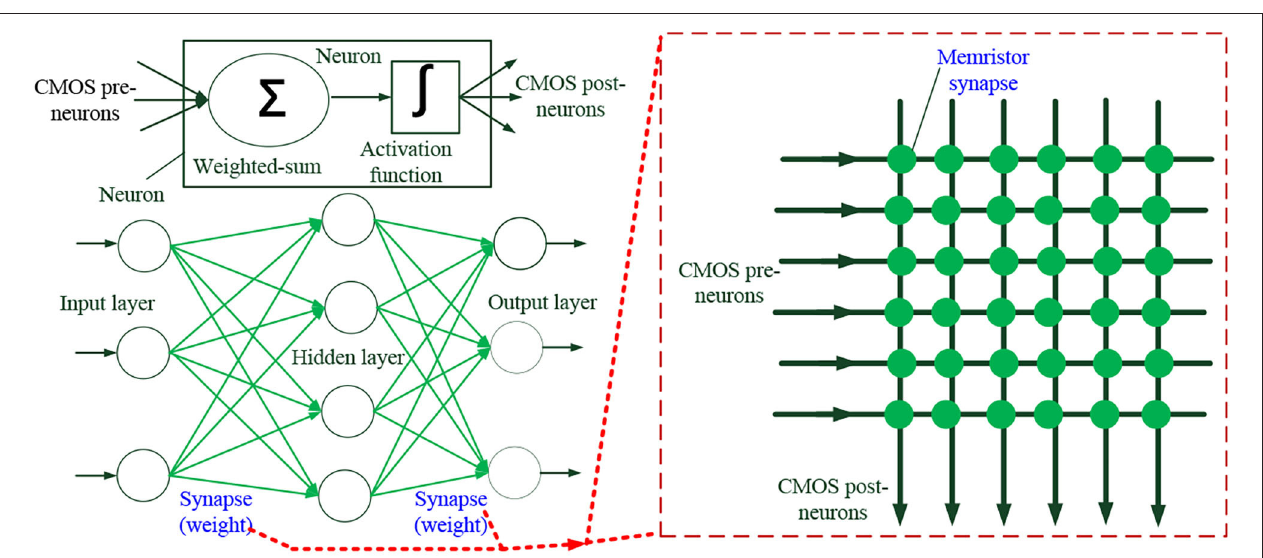
weights represent the connection strengths between two neurons.